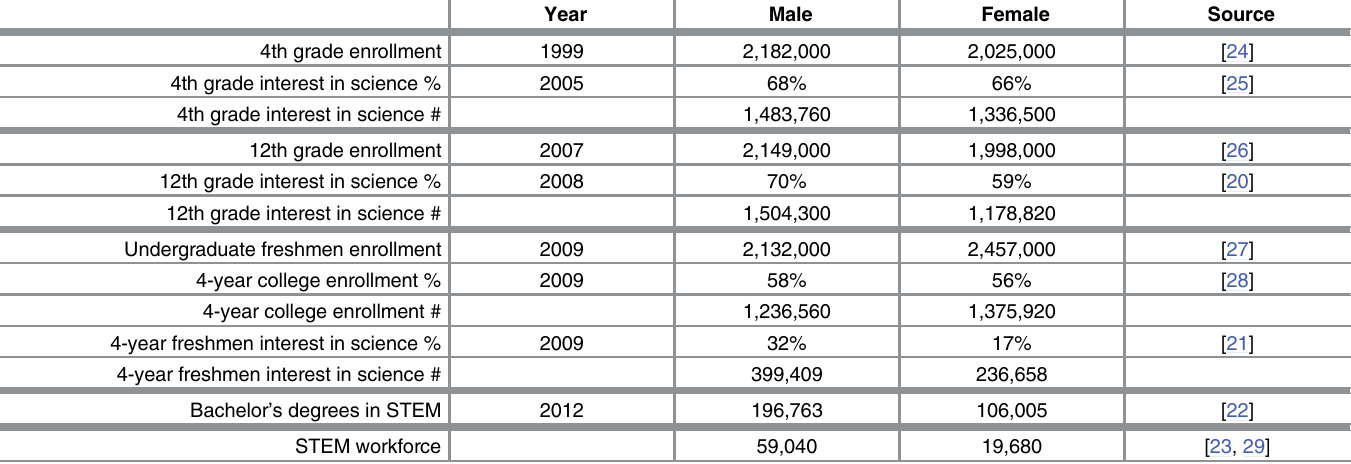
Table 1. STEM participation by gender from primary school to the STEM